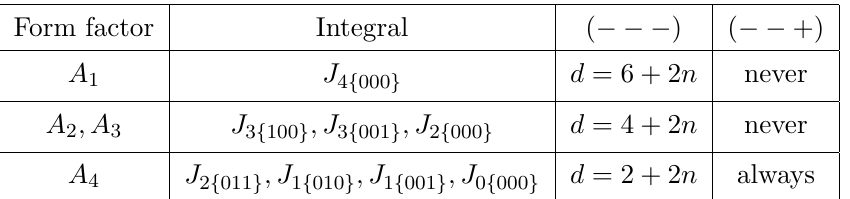
Table 2 . Singularities of triple- K integrals in the form factors for h T (cid:22)